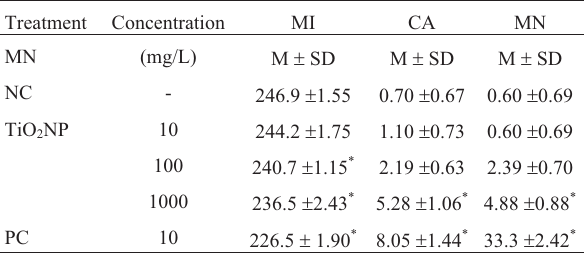
Table 2 - Alterations in meristematic cells of Allium cepa exposed to dif- ferent suspensions of titanium dioxide nanoparticles (TiO 2 NP). Treatment Concentration MI